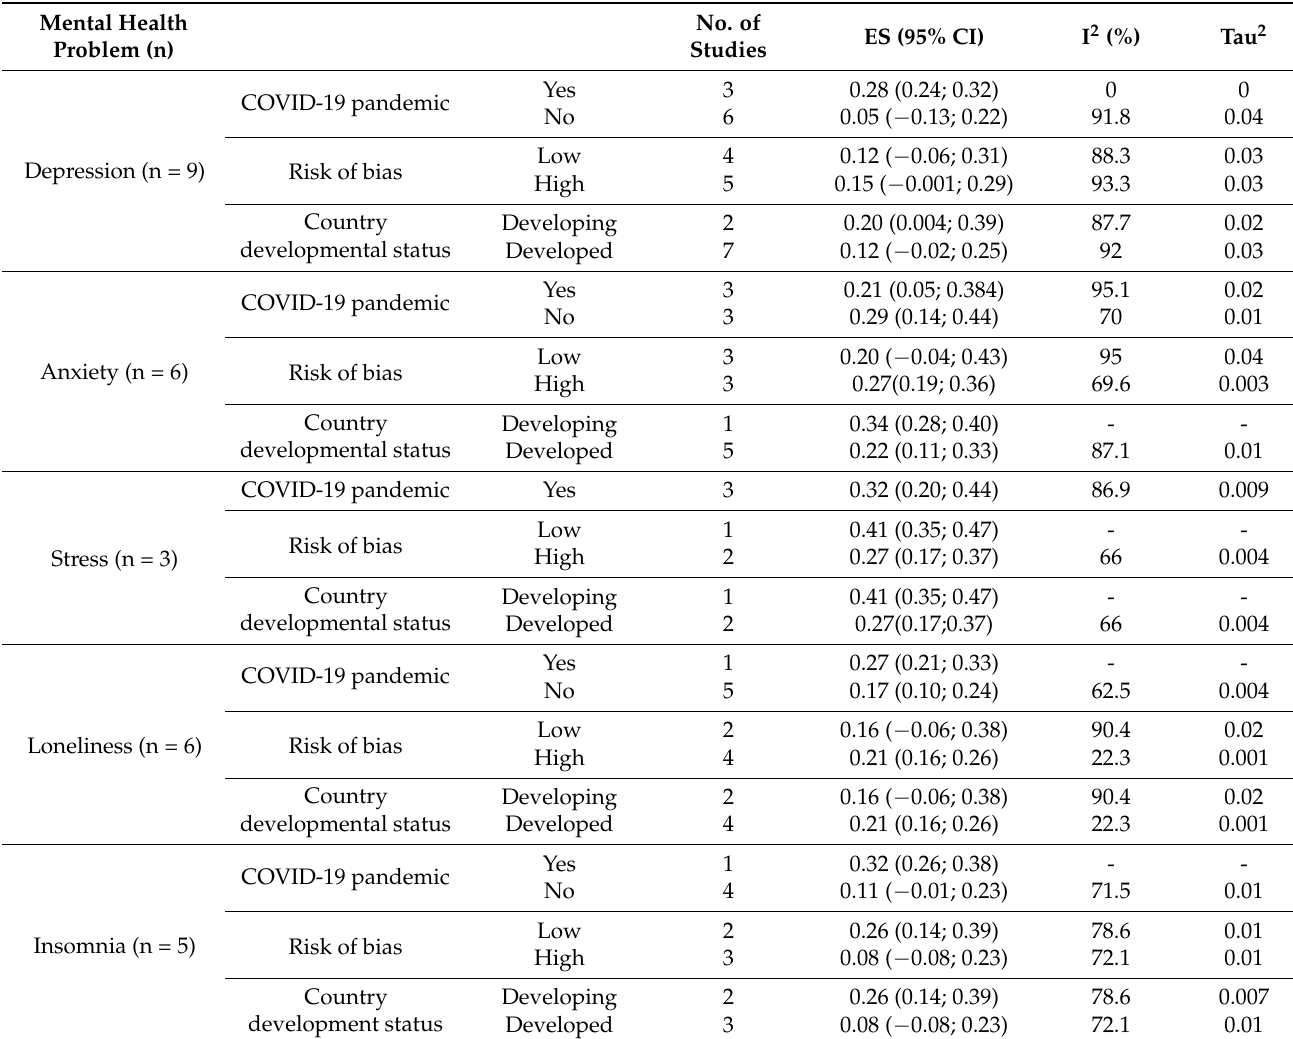
Table 3. The subgroup analyses for the associations between binge-watching and mental health